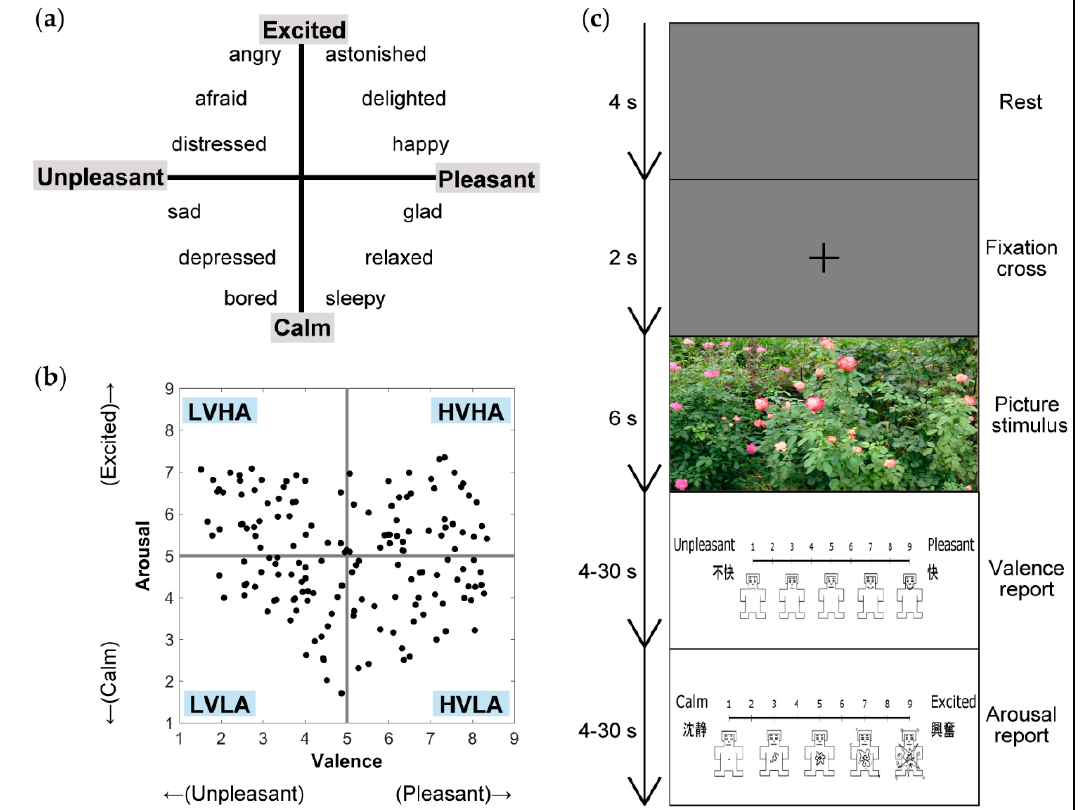
Figure 1. Experimental settings. ( a ) Schema of Russell’s valence ‒ arousal model [5]. ( b ) The distribution of the International Affective Picture System normative ratings of the 160 pictures used in the current study. On the valence axis, values of 9, 5, and 1 represent pleasant, neutral, and unpleasant states, respectively. On the arousal axis, values of 9, 5, and 1 represent excited, neutral, and calm states, respectively. HVHA, high valence and high arousal; HVLA, high valence and low arousal; LVHA, low valence and high arousal; LVLA, low valence and low arousal. ( c ) Trial flow. Each trial consisted of 4 s of rest, 2 s of fixation cross presentation, 6 s of picture stimulus presentation, and 4 ‒ 30 s of reporting of the felt valence and arousal levels. Valence and arousal levels were reported using a computerized visual analog scale with a self-assessment manikin (SAM; [11]). In the valence and arousal reporting scales, the emotions were written in English and Japanese at both ends of the scales.